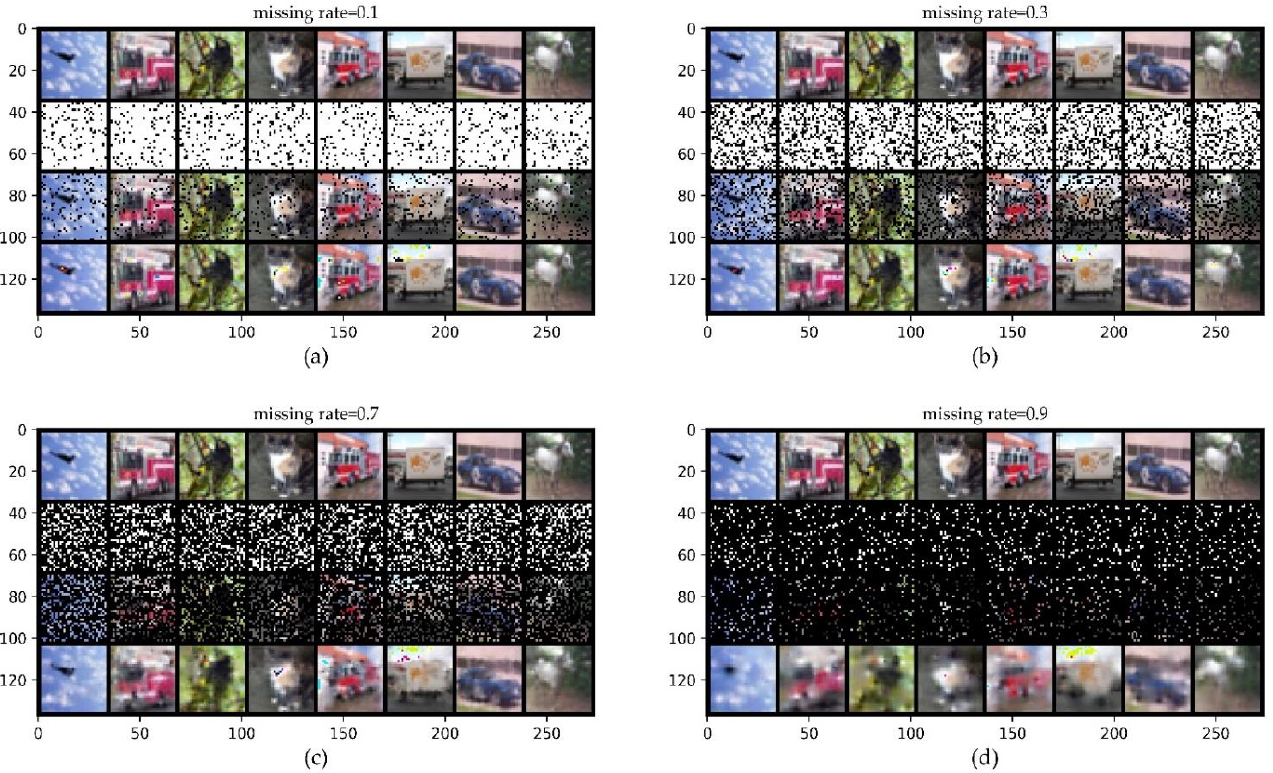
Figure 8. ConvCNPs-Net for CIFAR10 with MR. ( a – d ) show that the missing rate takes values from [0.1, 0.3, 0.7, 0.9], respectively, to test the performance of the trained ConvCNPs-Net and ConvCNP–SDE models. For each panel, the top row shows the original ID data of CIFAR10, the second row demonstrates the mask based on MR, the third row exhibits the CIFAR10 data with the mask, and the bottom row displays how the masked CIFAR10 data are completed by the ConvCNPs of the ConvCNP–SDE model.